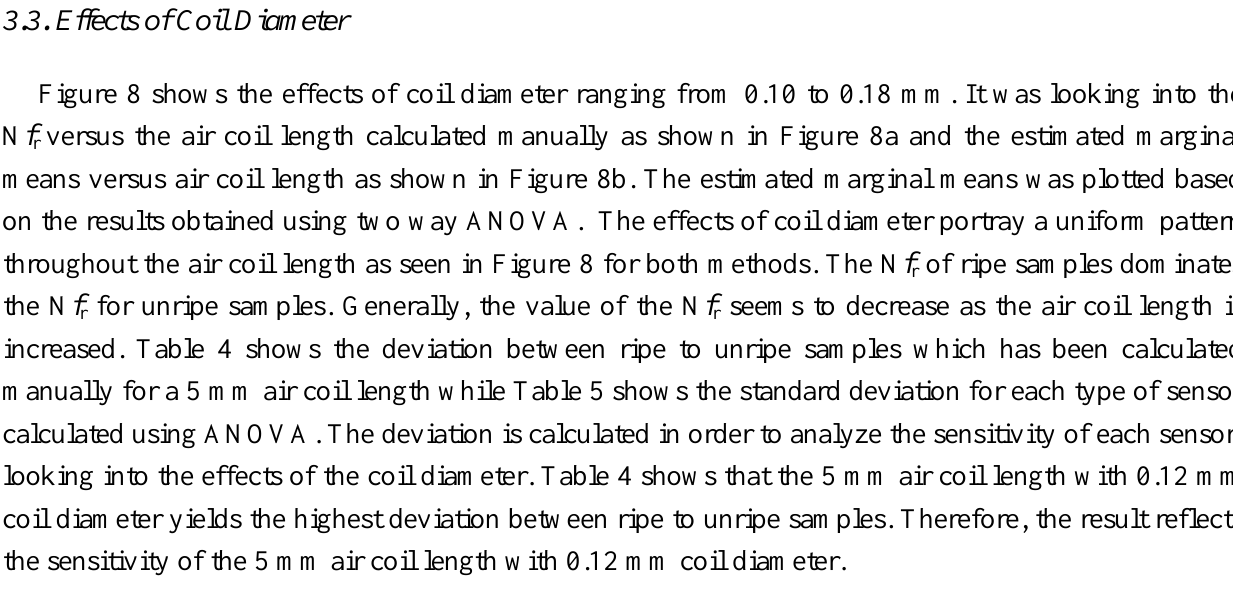
for coil diameter versus air coil length, r